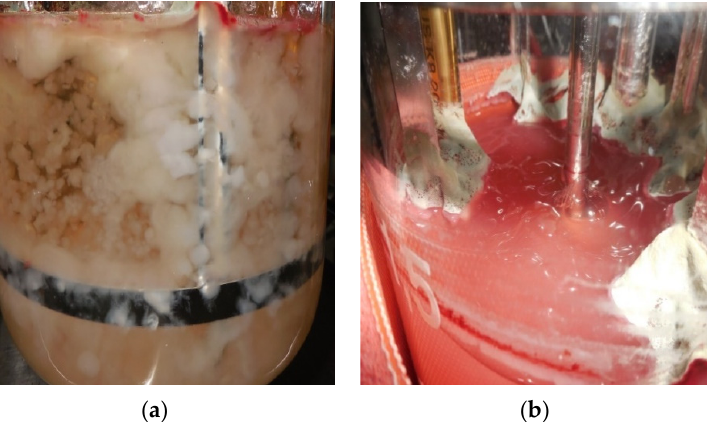
Figure 1. Stirred-tank 2 L bioreactor with pigments produced in the submerged fermentation of T. albobiverticillius 30548 in PDB, on day 7. ( a ) Agitation at 30 rpm with 100% pO 2 , ( b ) agitation at 200 rpm with 50% pO 2 .